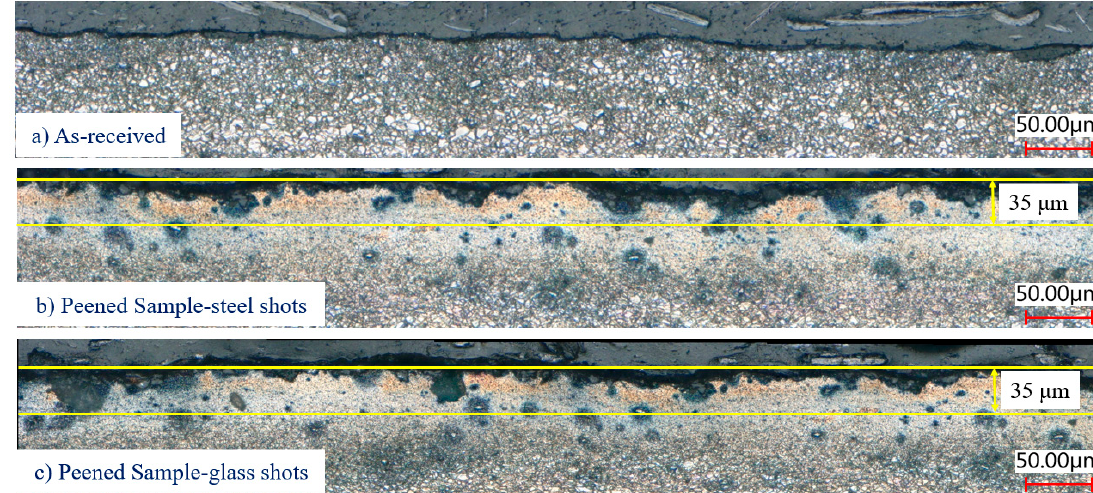
Figure 10. Cross-section of ( a ) the as-received sample, ( b ) peened using steel shots, and ( c ) peened using glass shots, showing much higher roughness in the shot peened samples as compared to the as-received sample.